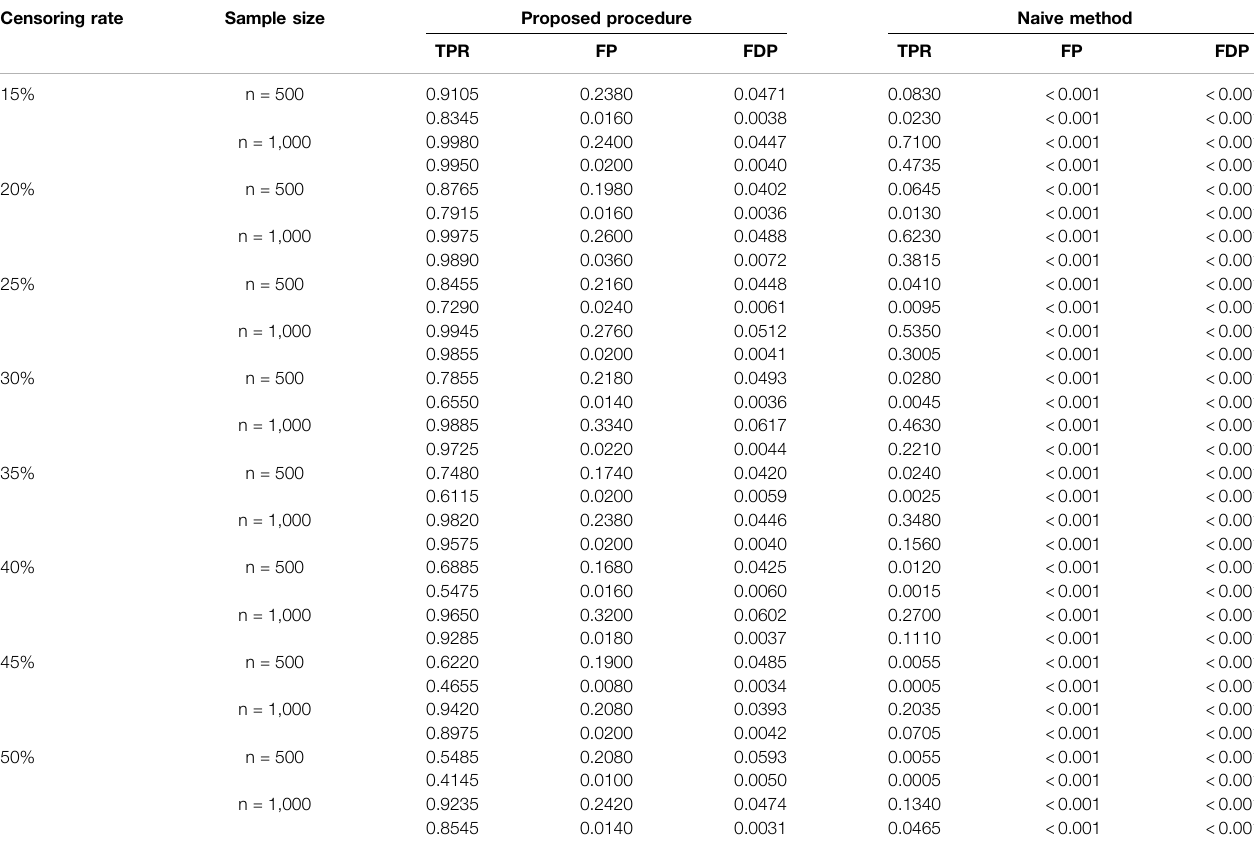
TABLE 1 | Select accuracy of the proposed procedure compared with naive